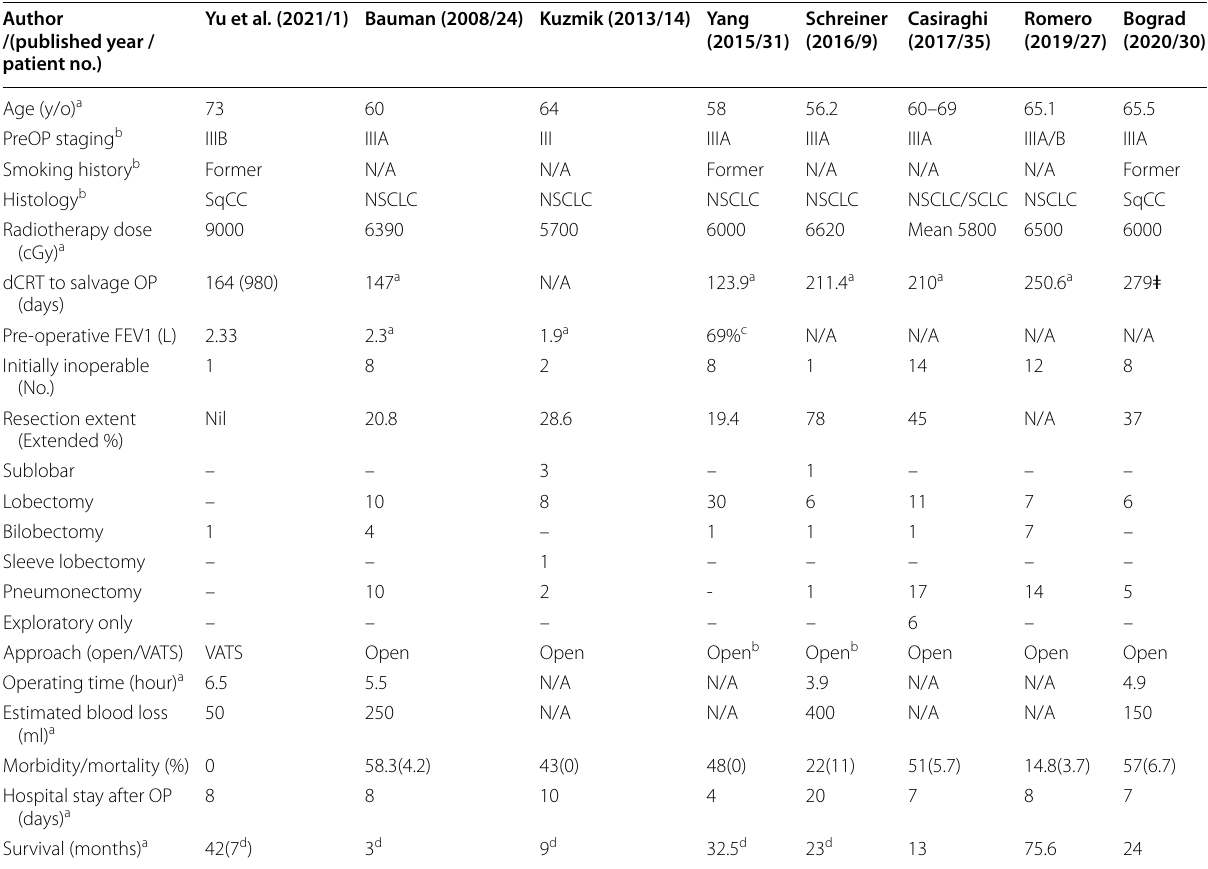
Table 1 Literature review: salvage surgery after dCRT with high‑dose